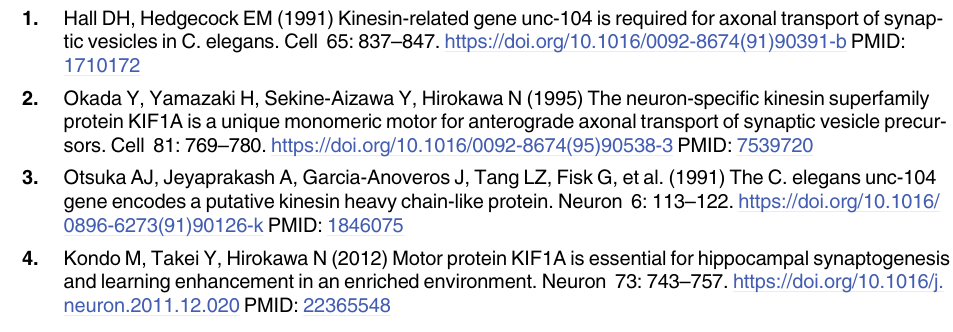
could be suppressed L170Q or K427A mutation (M) Quantification of the misaccumulated GFP::RAB-3 puncta in the asynaptic region and commissure region. The synaptic region is shown on the top. Scale bar represents 25 μ m. (N) Quantification of the length of the asynaptic region. ��� P < 0.001, one-way ANOVA with Tamhane’s T2 test. Mean ± SEM, N > = 20 worms for each genotype. S1 Table. Data collection and structural refinement statistics. S2 Table. Strains with